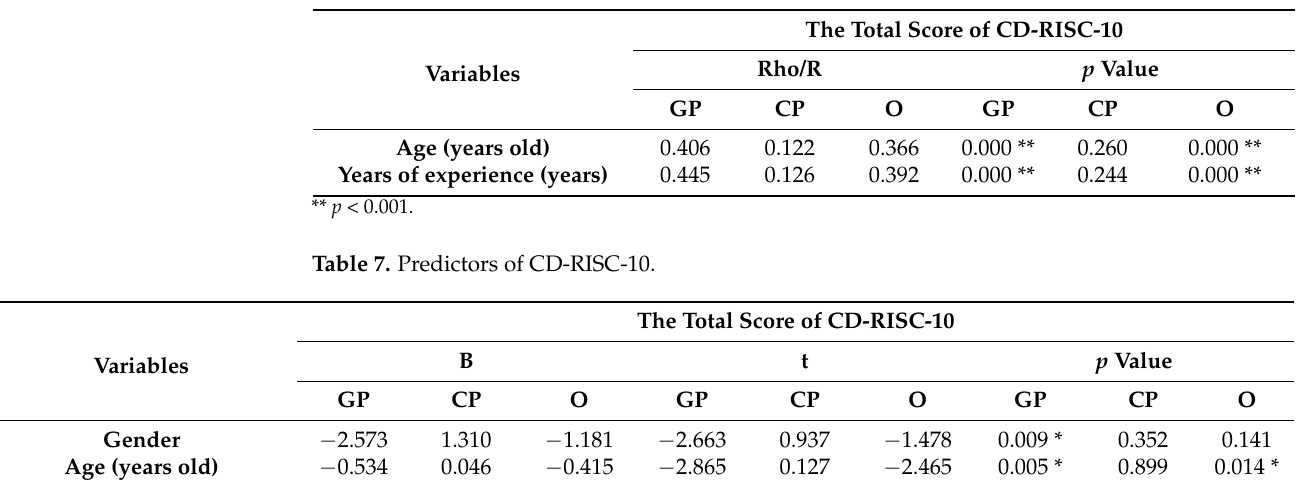
Table 6. Correlations between independent variables with CD-RISC-10.